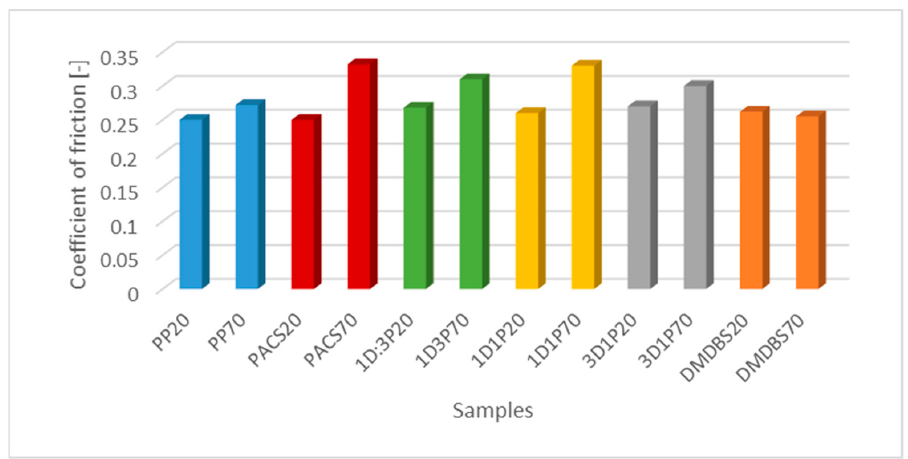
Figure 6. The steady state values of the coefficient of friction of the PP samples with various NA’s composition produced by two mold temperature 20 °C and 70 °C.